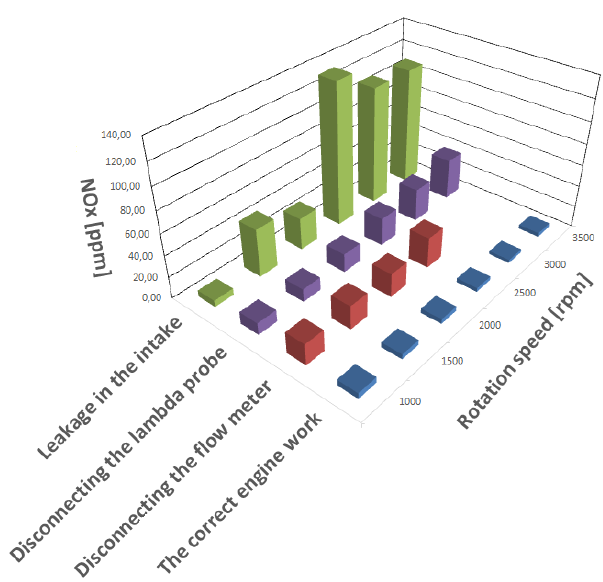
Fig. 13. The content of nitrogen oxides in the exhaust gas of a BMW engine fueled with petrol working efficiently and for simulated damage